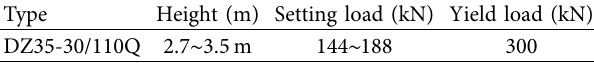
Table 3: Technical parameters of individual hydraulic props.